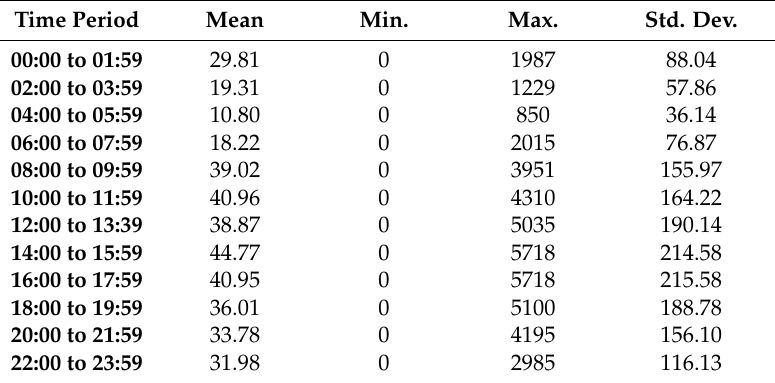
Table 2. Descriptive statistics for the temporal variation of calls-for-service. Note that 00:00 refers to midnight and 12:00 refers to noon.